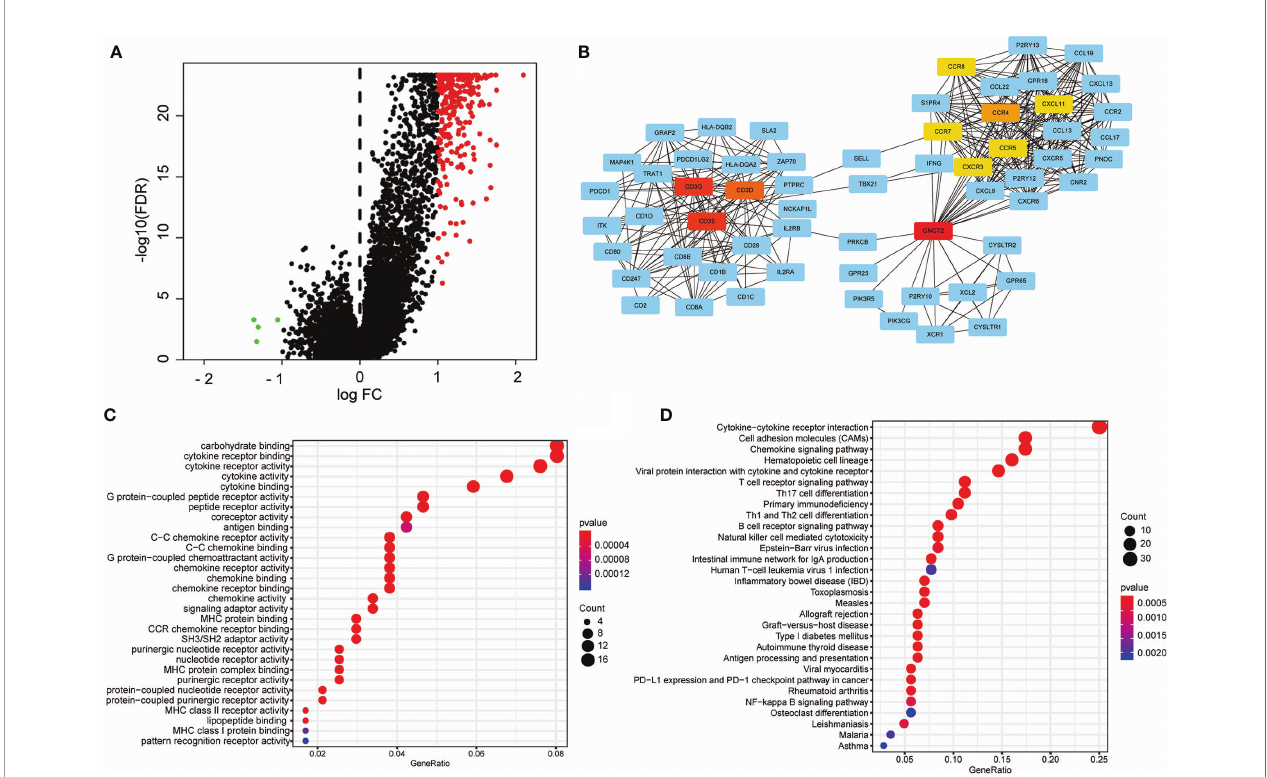
FIGURE 7 | Construction of the PPI network with differentially expressed genes active in C HIM patients. (A) Volcano plot of differentially expressed genes between C HIM and C LIM patients. (B) PPI network constructed by differentially expressed genes. Only 61 hub genes are shown. Centered genes are highlighted in yellow or red. (C, D) Molecular function and KEGG enrichments of hub genes of the PPI